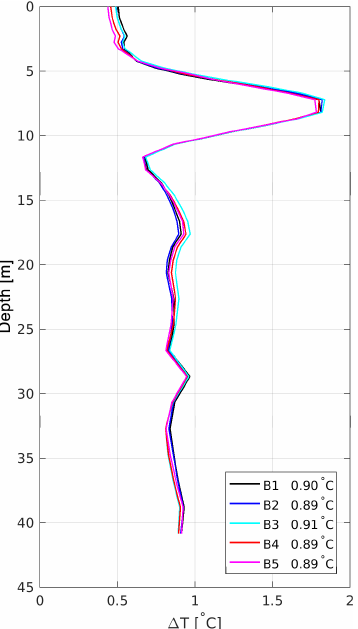
Figure 13. ROMS runs B1–B5: the rms temperature differences (cid:49)T [ ◦ C] between the modelled temperature T ROMS and the observed temperature T obs evaluated at the actual depths of the observations. The vertical mean (cid:49)T is written in the second column of the legend box. (cid:49)T was computed only for the period after 15 June at